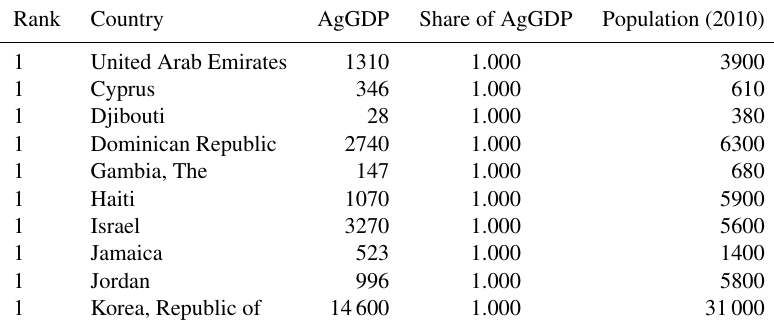
Table B5. Top 10 countries with the largest share of agricultural GDP in countries exposed to WCI areas with agricultural GDP (mil- lions of USD) and population (thousands).